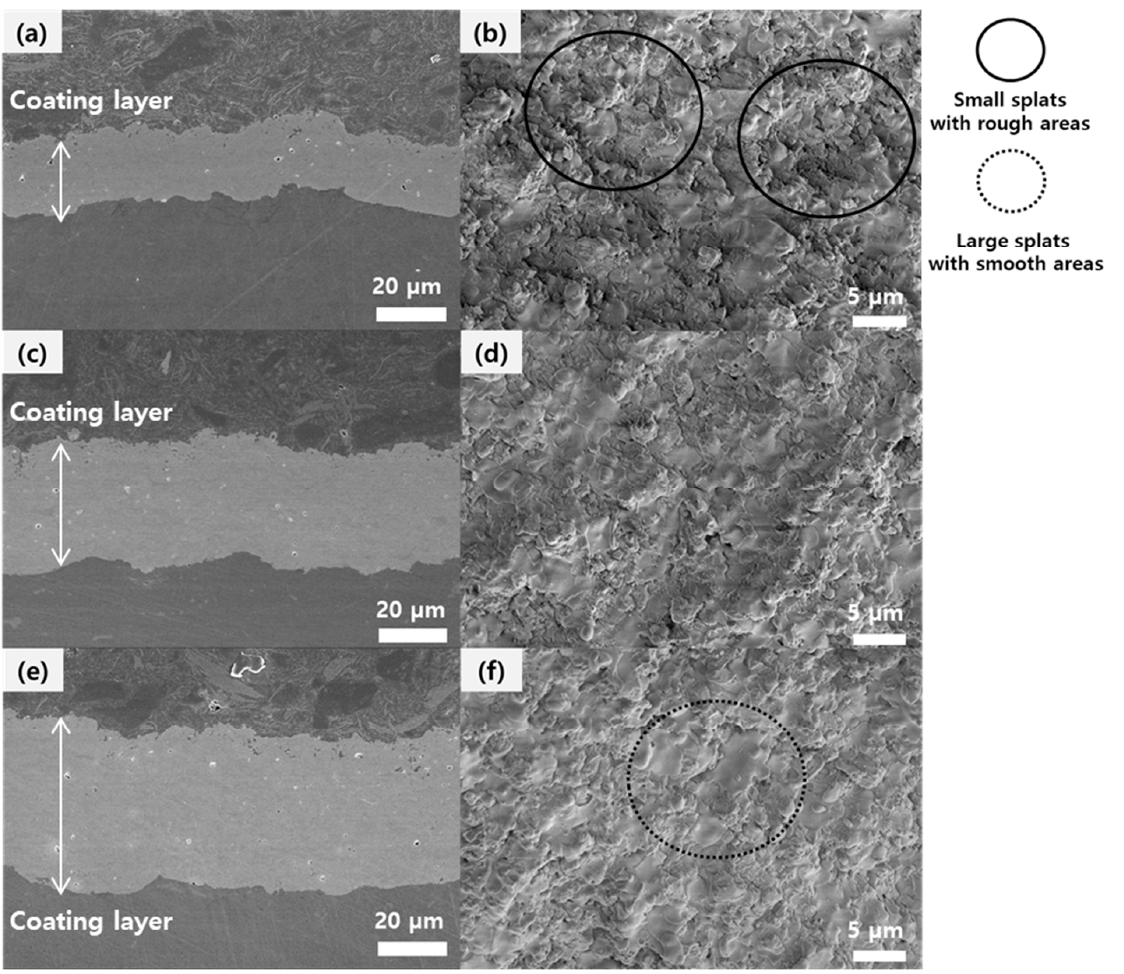
Figure 9. FE-SEM images of the cross-sectional ( a , c , e ) and surface ( b , d , f ) microstructures of YOF coatings deposited by the SPS process. ( a , b ) Y 5 O 4 F 7 suspension without dispersant; ( c , d ) electrostatically stabilized Y 5 O 4 F 7 suspension; ( e , f ) electrosterically stabilized Y 5 O 4 F 7 suspension.